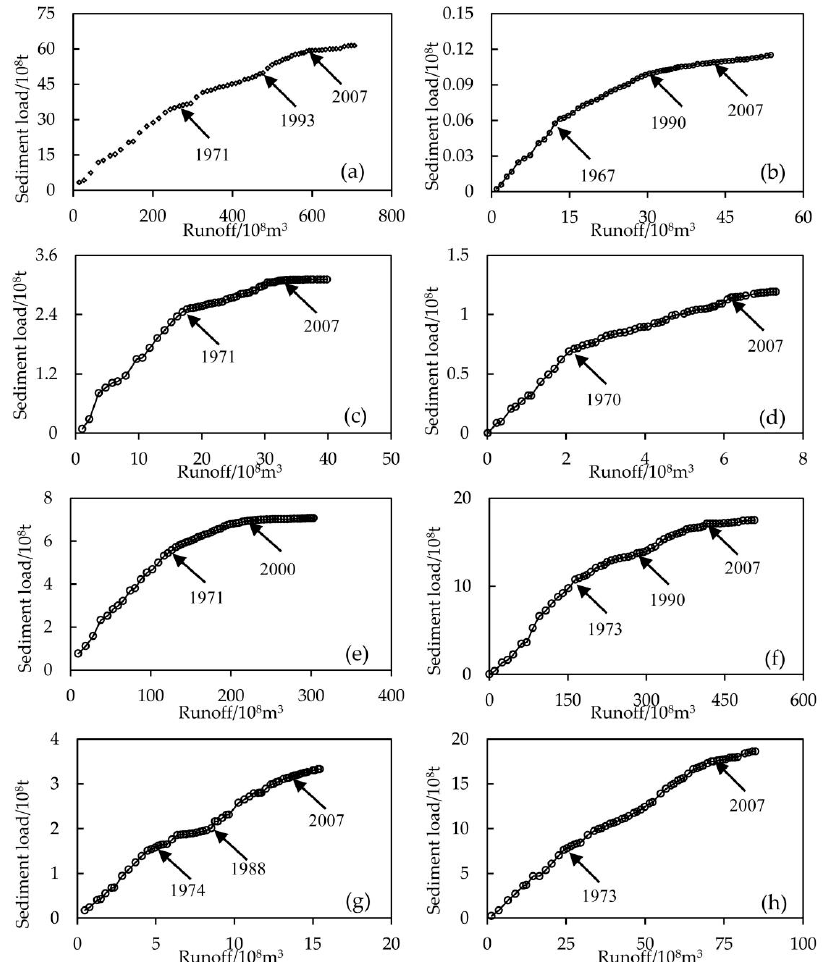
Figure 4. Double cumulative curve of runoff and sediment discharge in the Wuding River basin. ( a ) Baijianchuan gauging station; ( b ) Hanjiamao gauging station; ( c ) Hengshan gauging station; ( d ) Dianshi gauging station; ( e ) Zhaoshiyao gauging station; ( f ) Dingjiagou gauging station; ( g ) Lijiahe Gauging station; ( h ) Suide gauging station.